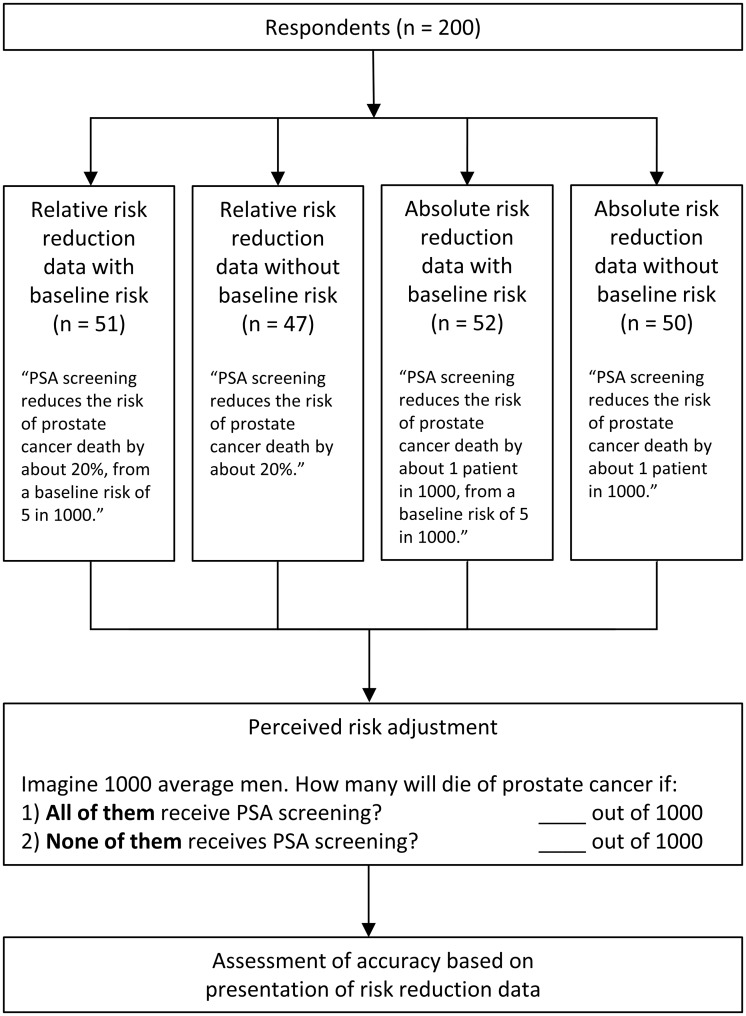
Study design and perceived risk reduction task based on data presentation.